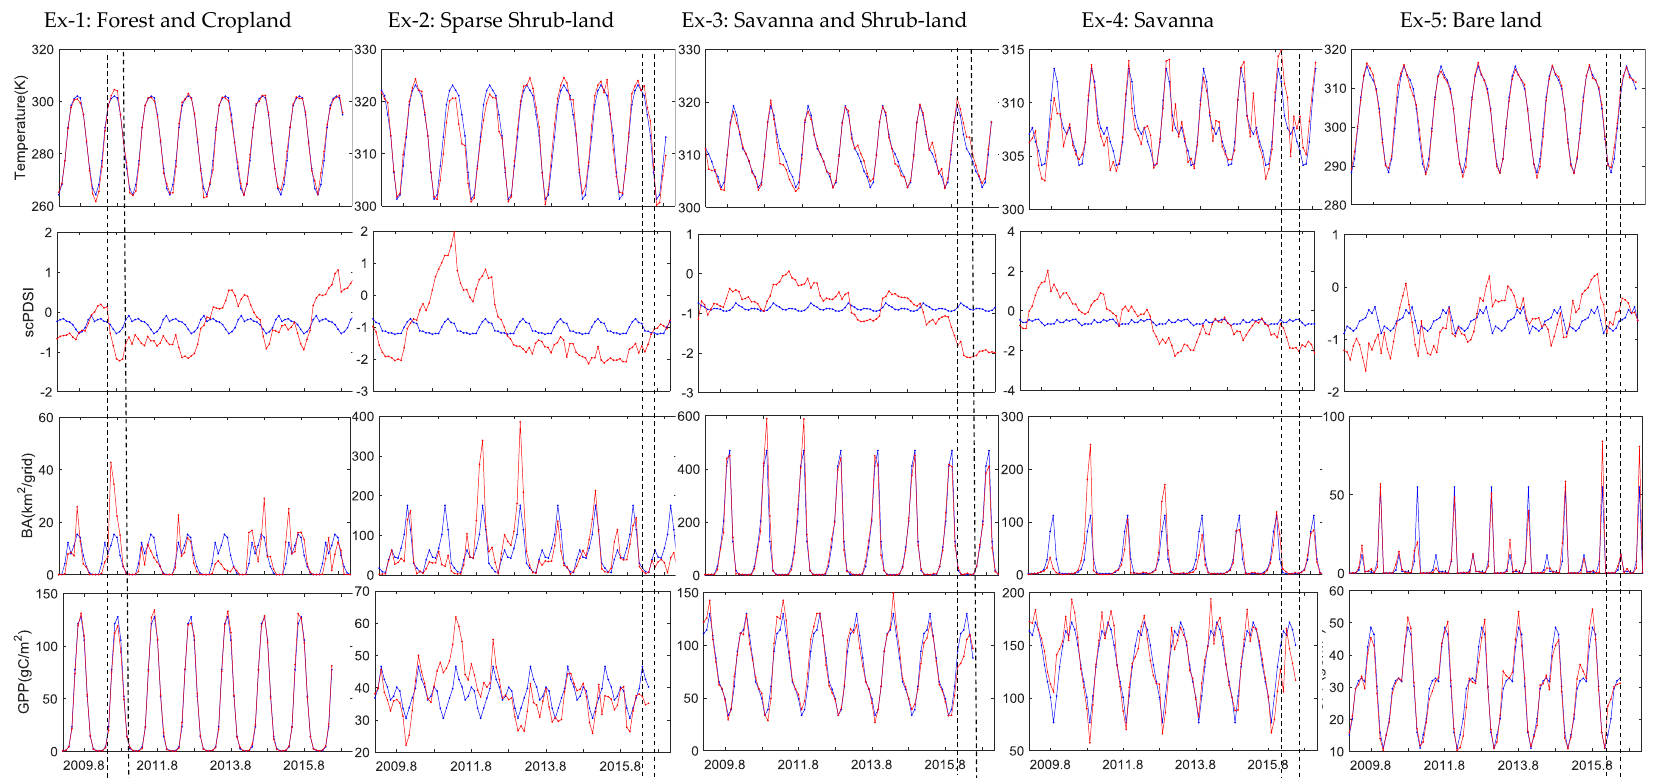
Figure 4. Monthly data, from 2009 to 2016, of parameters including surface skin temperature (Temperature), scPDSI, BA and GPP over detected high XCO 2 extreme units 1~5. Red line is the observed dataset and the blue line is seasonal mean data over the 8 years, calculated using the observed data. Time within black dashed lines indicates each extreme high XCO 2 unit.